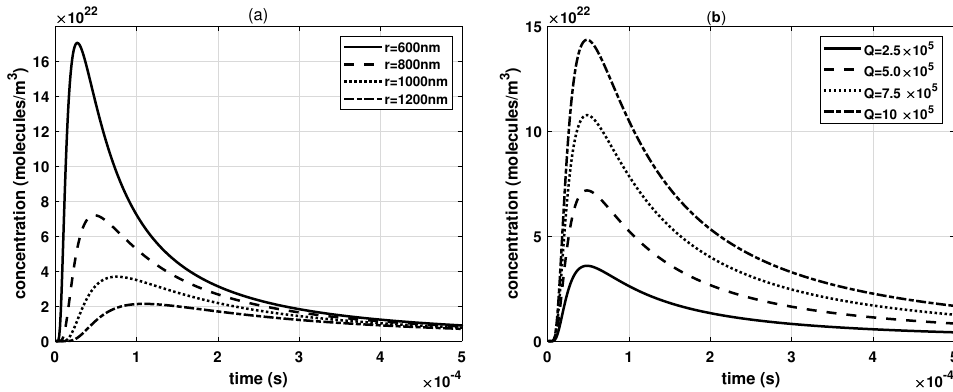
Figure 1. Concentration c ( t ) over time with varying ( a ) r and ( b ) Q